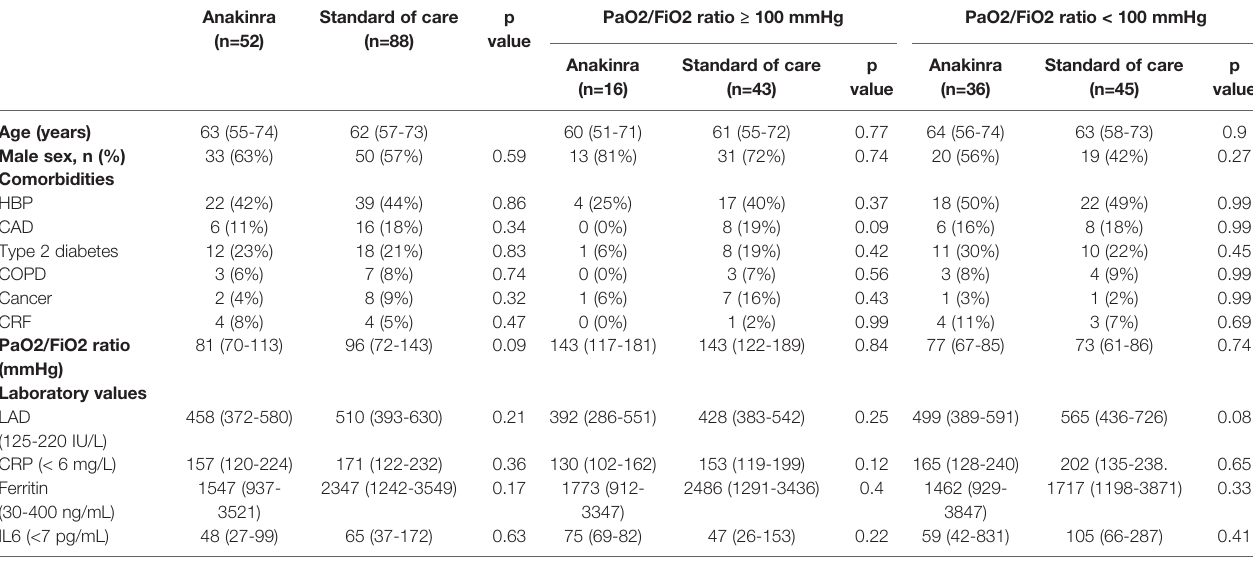
TABLE 2 | Clinical and serological features of patients treated with